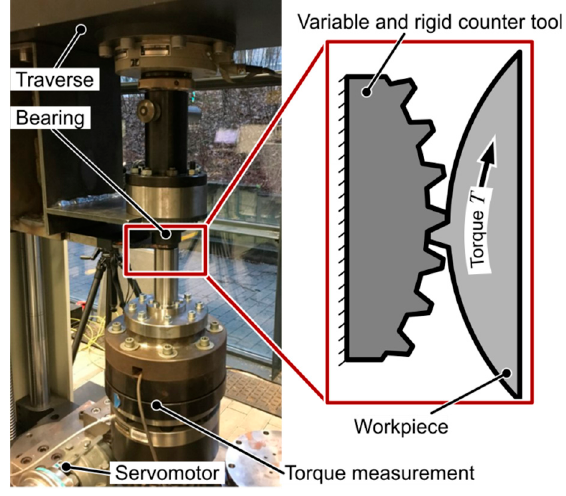
Figure 9. Setup of the benchmark-test.